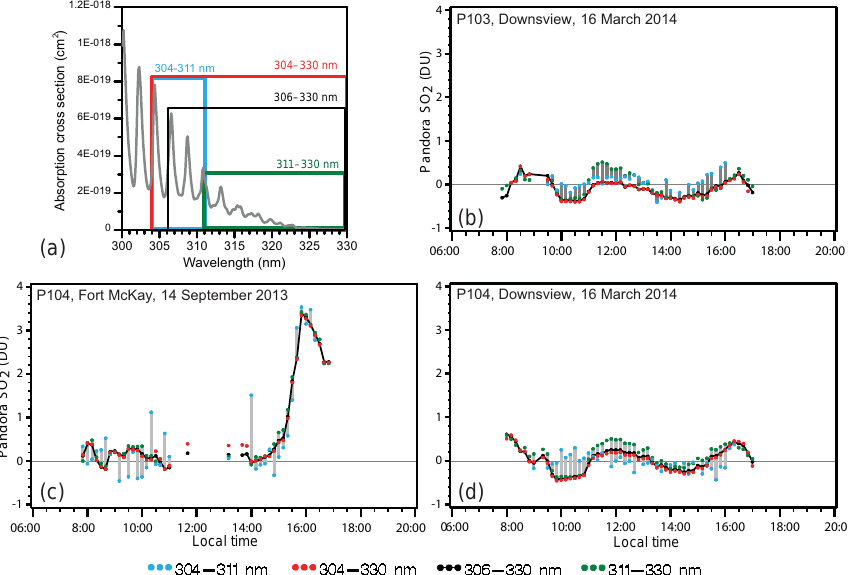
Figure 3. Examples of SO 2 VCD retrieved using different spectral windows as indicated on the plot. Data from Pandora 104 at Fort McKay, 14 September 2013, and Downsview, 16 March 2014, are shown. Different colours represent different spectral windows used for the fitting. Grey bars connect SO 2 values retrieved from 304–311 and 311–330nm spectral